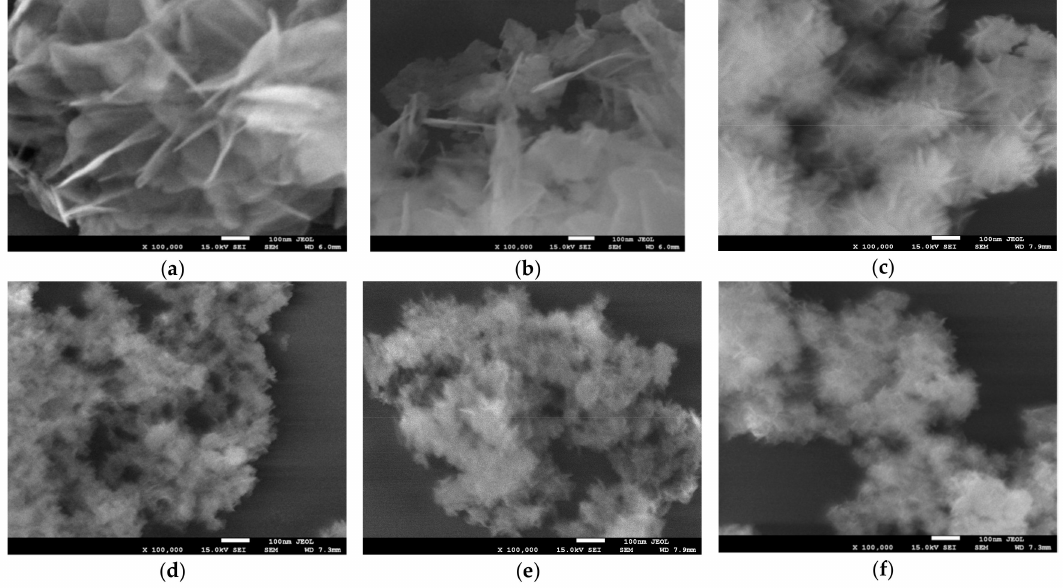
Figure 2. SEM images of Ht materials obtained with the use of di ff erent precipitating agents and in the presence or absence of various starches: ( a ) Ht NaOH ; ( b ) Ht NH3 ; ( c ) Ht NaOH 0.2POS ; ( d ) Ht NH3 0.2POS ; ( e ) Ht NH3 0.2COS and ( f ) Ht NH3 0.2CAS . Magnification ×